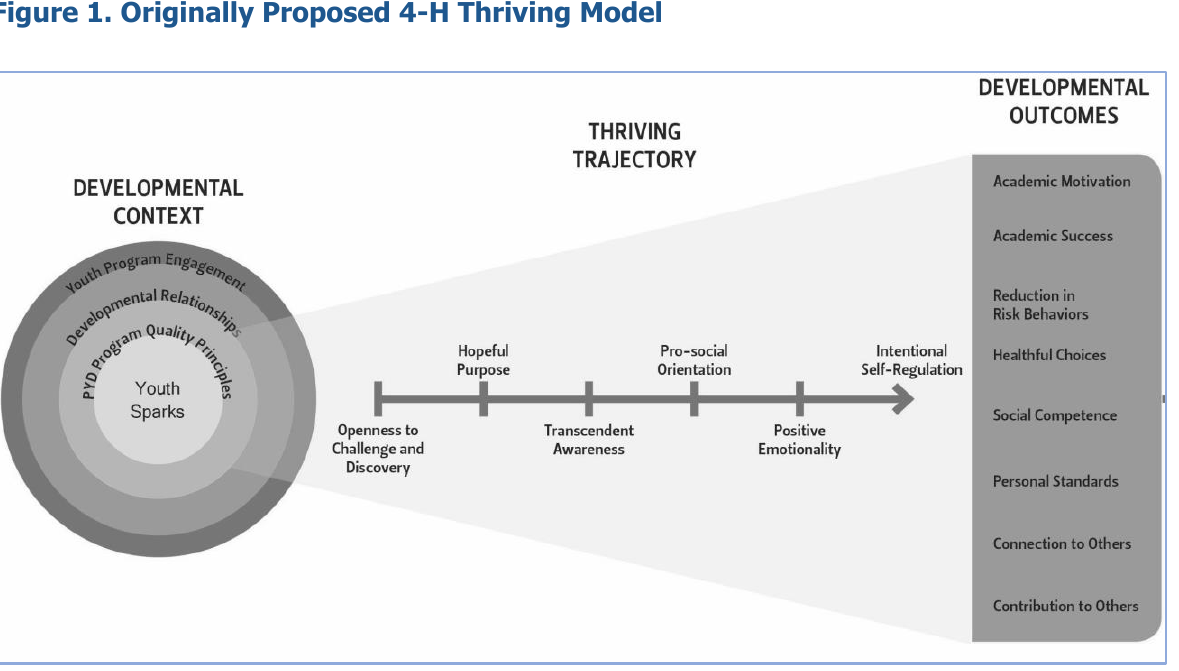
Figure 1. Originally Proposed 4-H Thriving